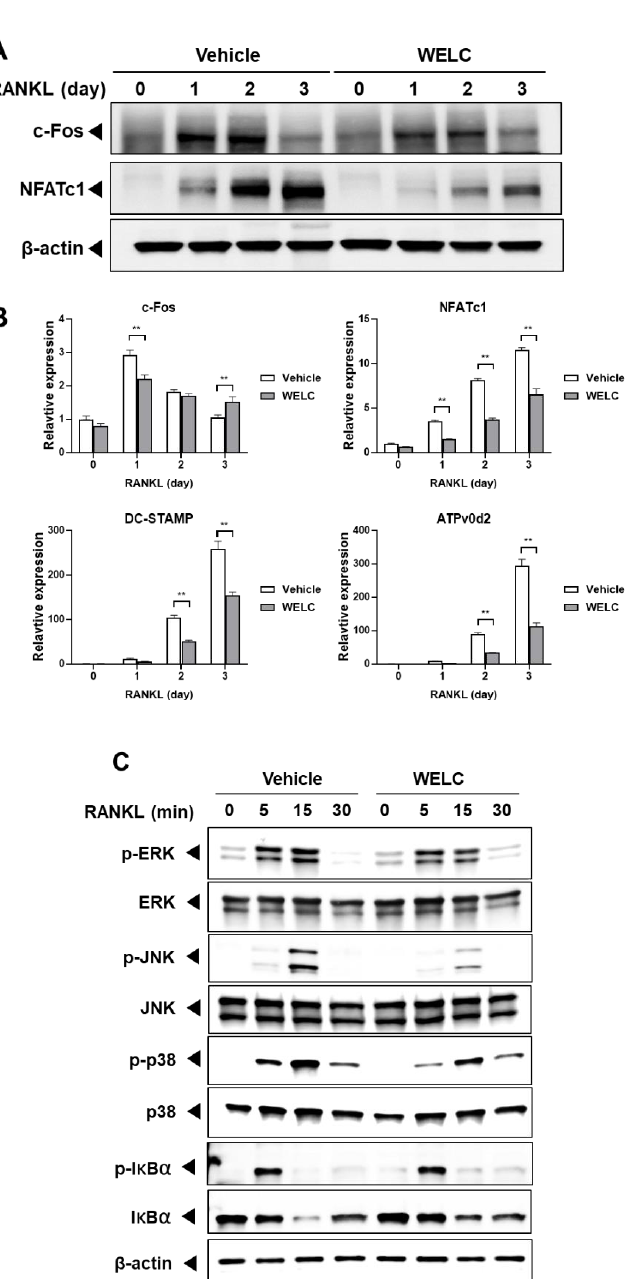
Figure 2. Inhibitory effects of WELC on RANK signaling pathways. ( A , B ) BMMs were pretreated with vehicle (distilled water) or WELC (200 µg/mL) and then simulated RANKL (50 ng/mL) for the indicated days. Day 0 represent BMMs untreated with RANKL for 1 day. ( A ) The protein levels of c-Fos, NFATc1, and β -actin were analyzed by Western blot analysis ( B ) The relative gene expression levels of c-Fos, NFATc1, DC-STAMP, and ATPv0d2 were analyzed by RT-PCR and expressed as fold change relative to each control (day 0 untreated with WELC). ** p < 0.01 versus vehicle. ( C ) BMMs were pretreated with WELC for 3 h and then stimulated with RANKL for the indicated times. Protein levels were analyzed by western blot analysis with the indicated antibodies. BMMs, bone marrow-derived macrophage cells; RANKL, receptor activator of nuclear factor-kappa B ligand; NFATc1, nuclear factor of activated T-cells cytoplasmic 1; DC-STAMP, dendrocyte expressed seven transmembrane protein; Atp6v0d2, ATPase, H + transporting, lysosomal 38kDa, V0 subunit d2; WELC, water extract of Lysimachia christinae . RT-PCR, real-time polymerase chain